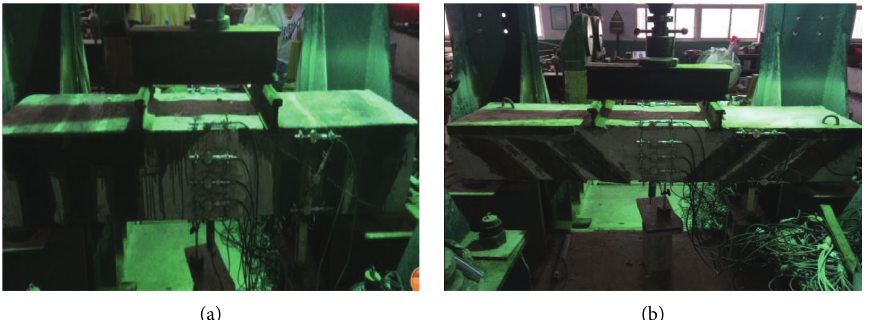
Figure 6: Static load test of prestressed hollow beam: (a) static load test of carbon cloth reinforcement and (b) steel plate reinforcement static load